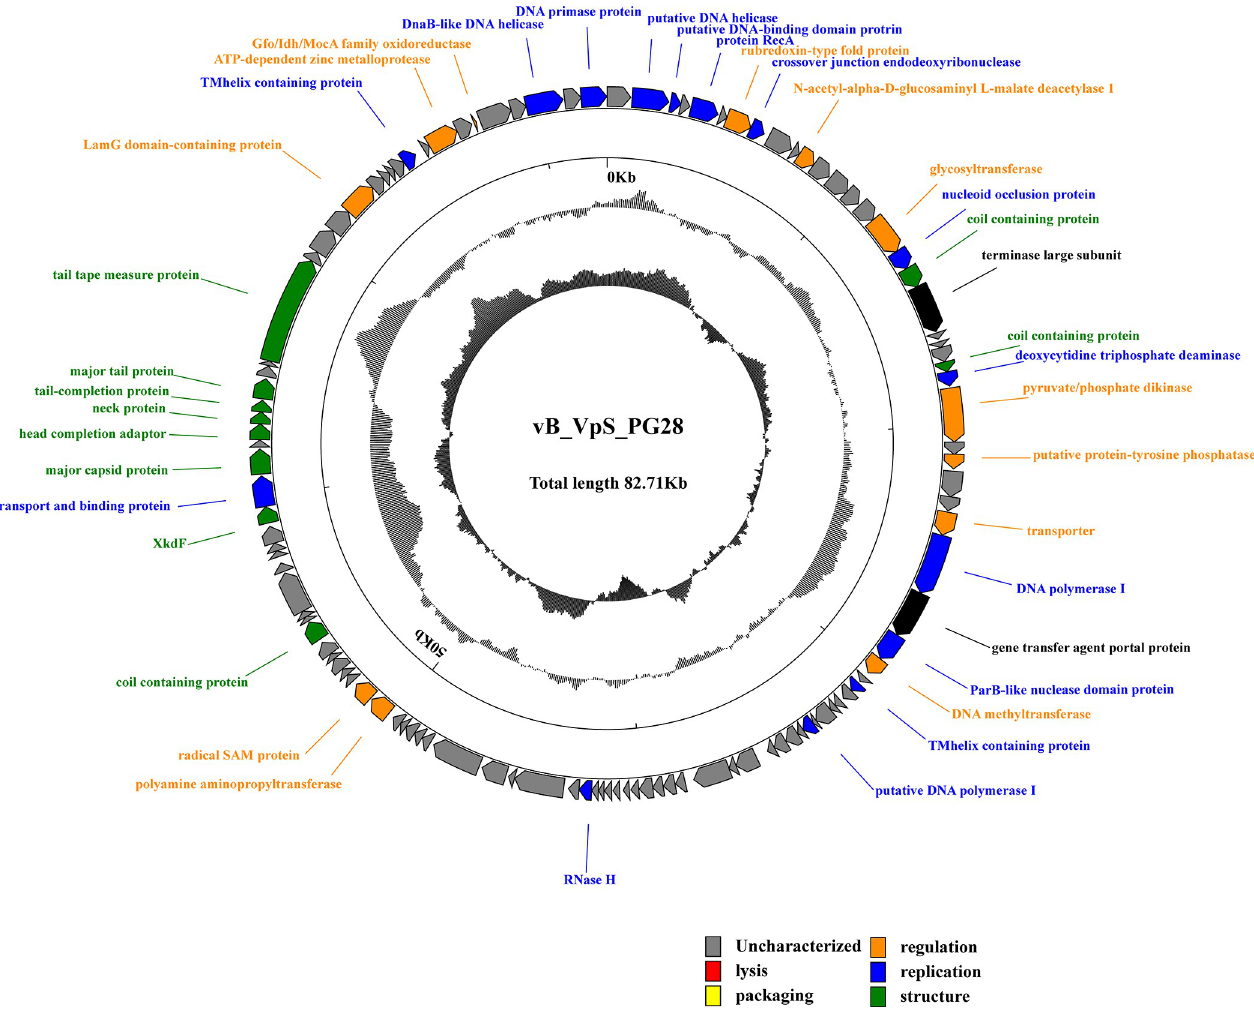
Fig 4. Circular map of the bacteriophage vB_VpS_PG28 genome. The innermost circle represents the GC skew (G − C/G + C. Outwards indicates > 0 and inwards indicates < 0). the dark circles in the middle represent the GC content (outwards indicates greater than the average GC content compared with the whole genome, and inwards indicates the opposite); The outermost circle represents ORFs encoded in the genome, with different colors representing different functions (clockwise arrow indicates the forward reading frame, counterclockwise arrow indicates the reverse reading frame).